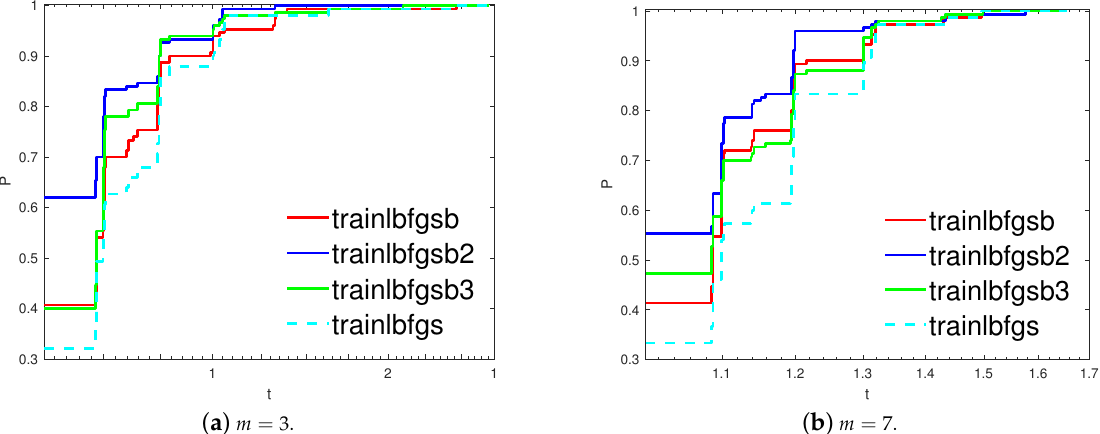
Figure 10. Log 10 scaled performance profiles based on F 1 -score for the Coimbra classification